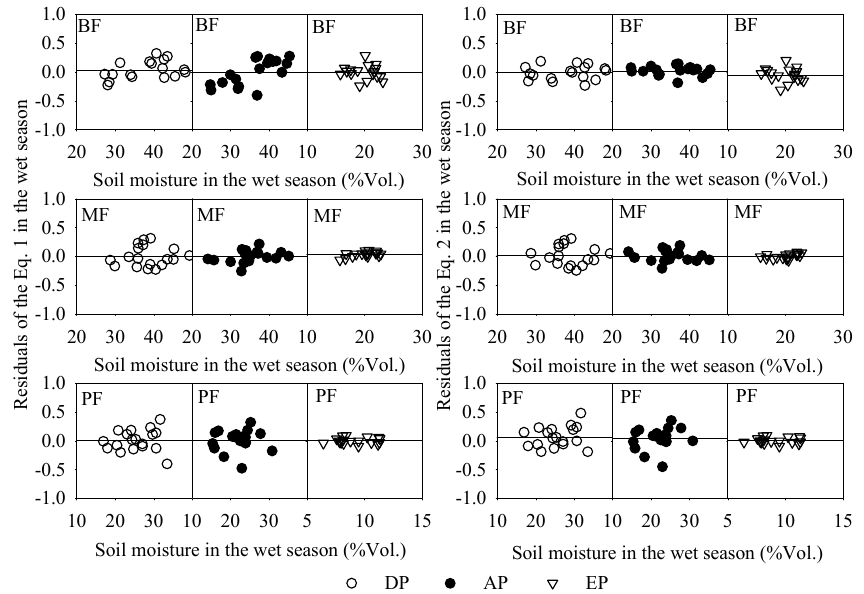
Fig. A7. Residual plots in the wet season for Eq. (1) ( R = (a 1 + c 1 M) exp (b 1 T ) ) and Eq. (2) ( R = (a 2 M 2 + c 2 M + d 2 ) exp (b 2 T ) ) under different precipitation treatments at the DNR forests. The treatments are as follows: precipitation exclusion (EP), ambient precipitation (AP), and double precipitation (DP). The forests are as follows: broadleaf forest (BF), mixed forest (MF), and pine forest